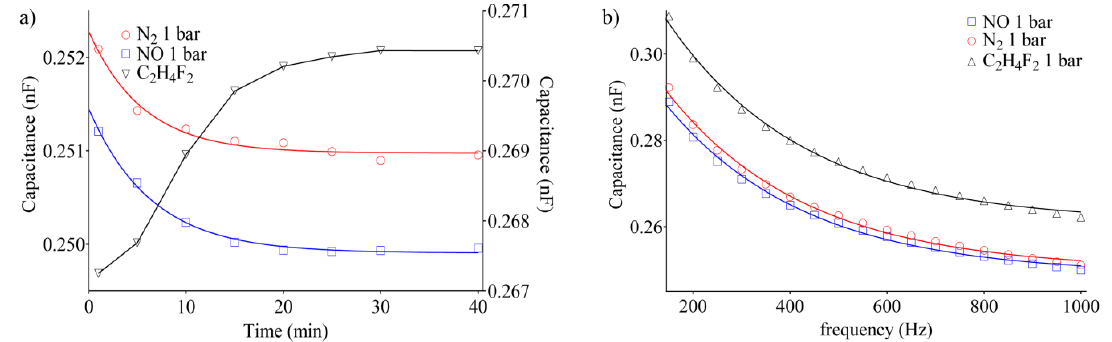
Figure 8. Adsorption of N 2 , NO, and C 2 H 4 F 2 by the Zeolite-based sensor. ( a ) Time behavior of capacitance and ( b ) frequency behavior of capacitance during the adsorption of the three different gases. In all cases, pressure was maintained at 1 bar.